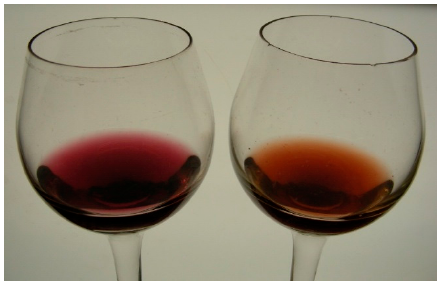
Figure 2. Wine browning by Botrytis -laccase (right).